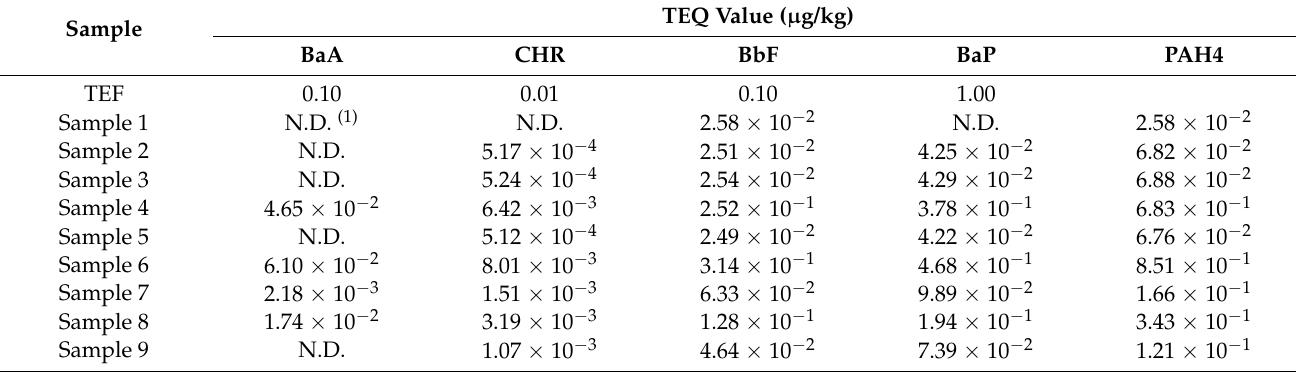
Table 6. TEQ values for PAH4 concentration in herbal medicines analyzed using QuEChERS pretreatment method.